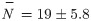
Uniform adaptation: Above the expansion threshold, the population expands gradually through the available habitat.(a) Trait (in blue) closely matches the environmental gradient (grey) along the x-axis. (b) Population steadily expands, whilst population density stays continuous across space, with N¯=19±5.8 (mean ± standard deviation). The prediction at N^=20 is shown by the blue contours; darker shading represents higher density. (c) Adaptation to the environmental gradient is maintained by a series of staggered clines: as each allele frequency changes from 0 to 1, the trait value increases by α. Population starts from the centre (blue hues reflect initial cline position relative to the centre of the range), and as it expands, new clines arising from loci previously fixed to 0 or 1 contribute to the adaptation (in red hues). At each location, multiple clines contribute to the trait (and variance); clines are shown at Y = 25. (d) Genetic variance changes continuously across space with mean V¯G=0.032±0.017 and stays slightly lower than is the deterministic prediction (green contours, VG = 0.045; higher variance is illustrated by darker shading). Deterministic predictions are based on [13] and are explained in the Methods section, along with the specification of the unscaled parameters. The population evolves for 2,000 generations, starting from a population adapted to the central habitat. The predicted neighbourhood size is N^=34.6; effective environmental gradient is B = 0.48.